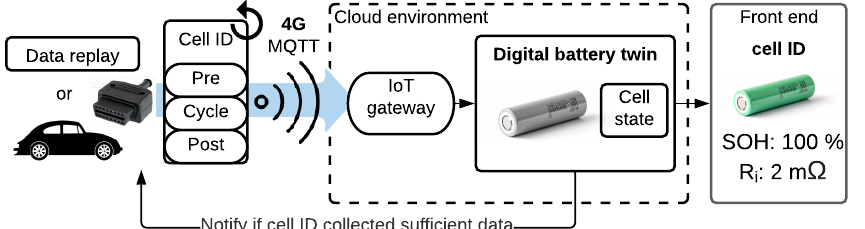
Figure 3. Toolchain to acquire and process the OBD data in a cloud-based digital twin and display on a web front